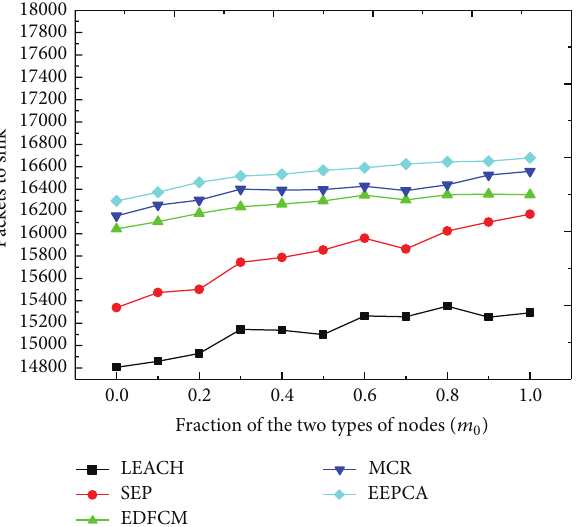
Figure 7: Packets to sink with varying number of sensor nodes.